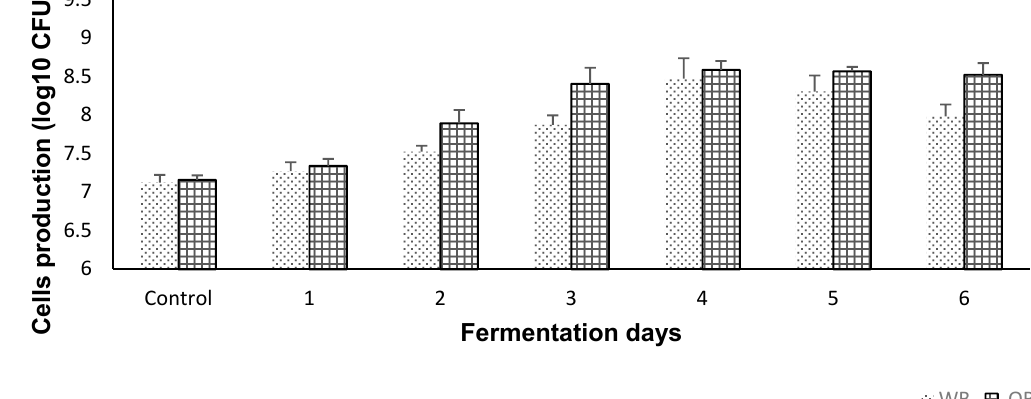
Figure 1. Cell viability (plate counting method) of the extracts (control and fermented (6 days)). Values are expressed as mean values ± SD, log10 CFU/g, n = 3, GraphPad Prism Version 8.0.1, Graph Pad Software, Inc. (San Diego, CA, USA).